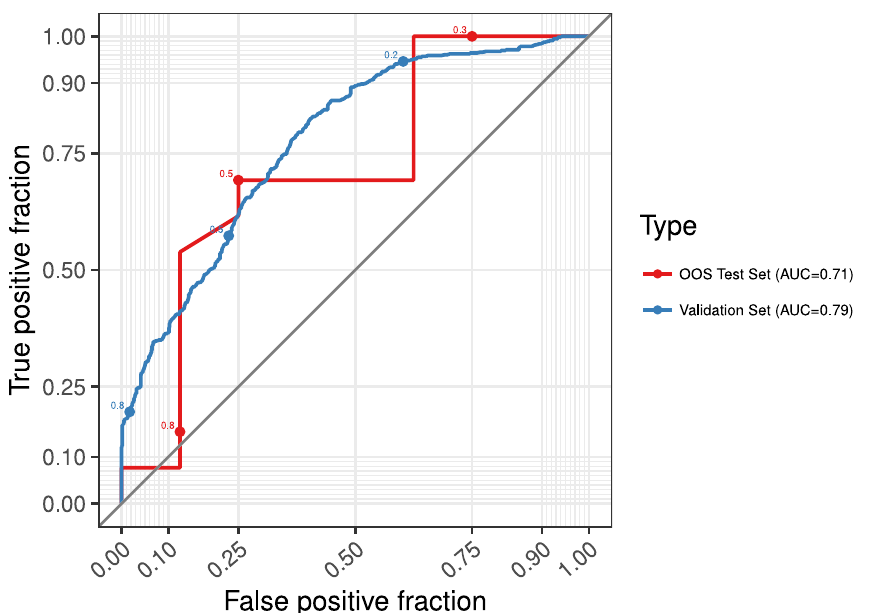
Fig 6. ROC curve for held-out validation sets from the best model during cross-validation and for the out of sample predictions. The plot shows the trade off between true positives (predicting correctly that a study will replicate) and false positives (predicting that a study will replicate when it in fact does not) as the decision threshold varies. At a threshold of 0.5 the model identifies about 70% of the successful replications and 75% of the non- replications correctly. If a user of the model wants to lower the risk of missclassifying a paper that would replicate as not replicating they can use a threshold of e.g. 0.3. At this level, the model misclassifies less than 10% of the successful replications. The price, however, is that almost 70% of non-replications will also be labeled as successful.